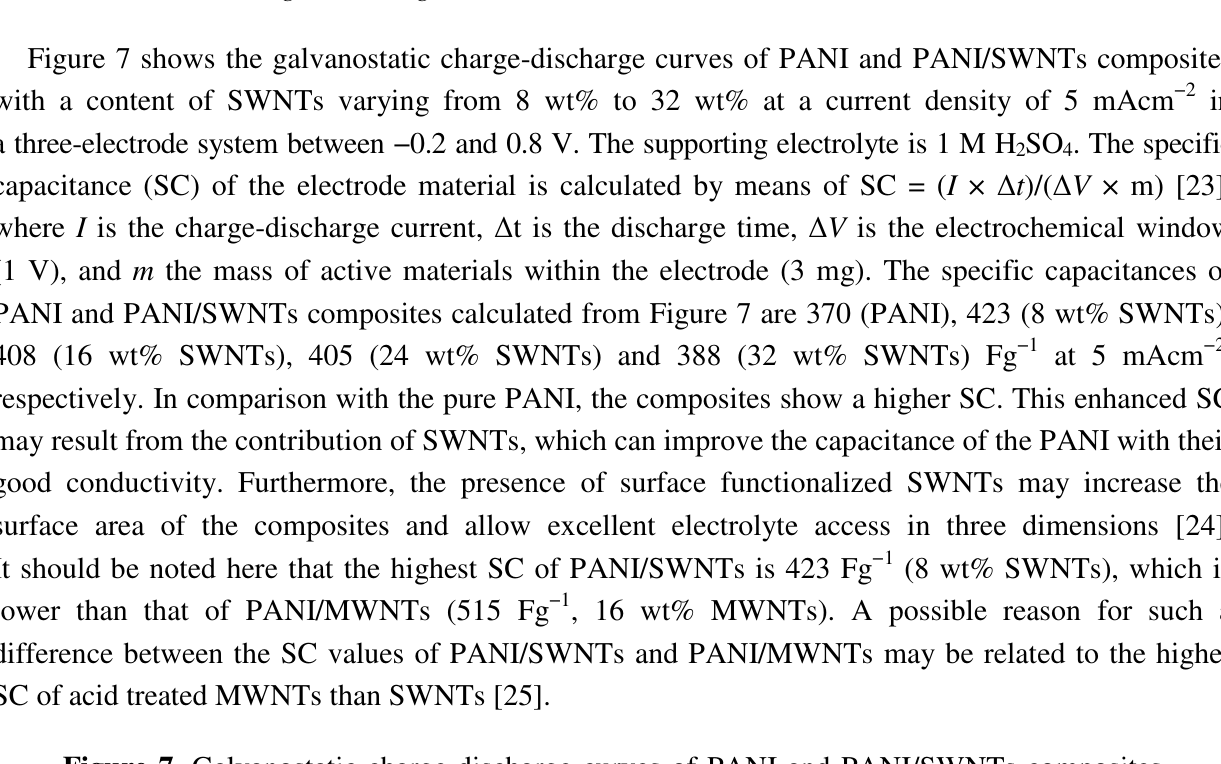
Figure 7. Galvanostatic charge-discharge curves of PANI and PANI/SWNTs composites with a content of SWNTs varying from 8 wt% to 32 wt% at current density of 5 mAcm −2 SO . Mass of the active material: 3 in 1 M H 2 4